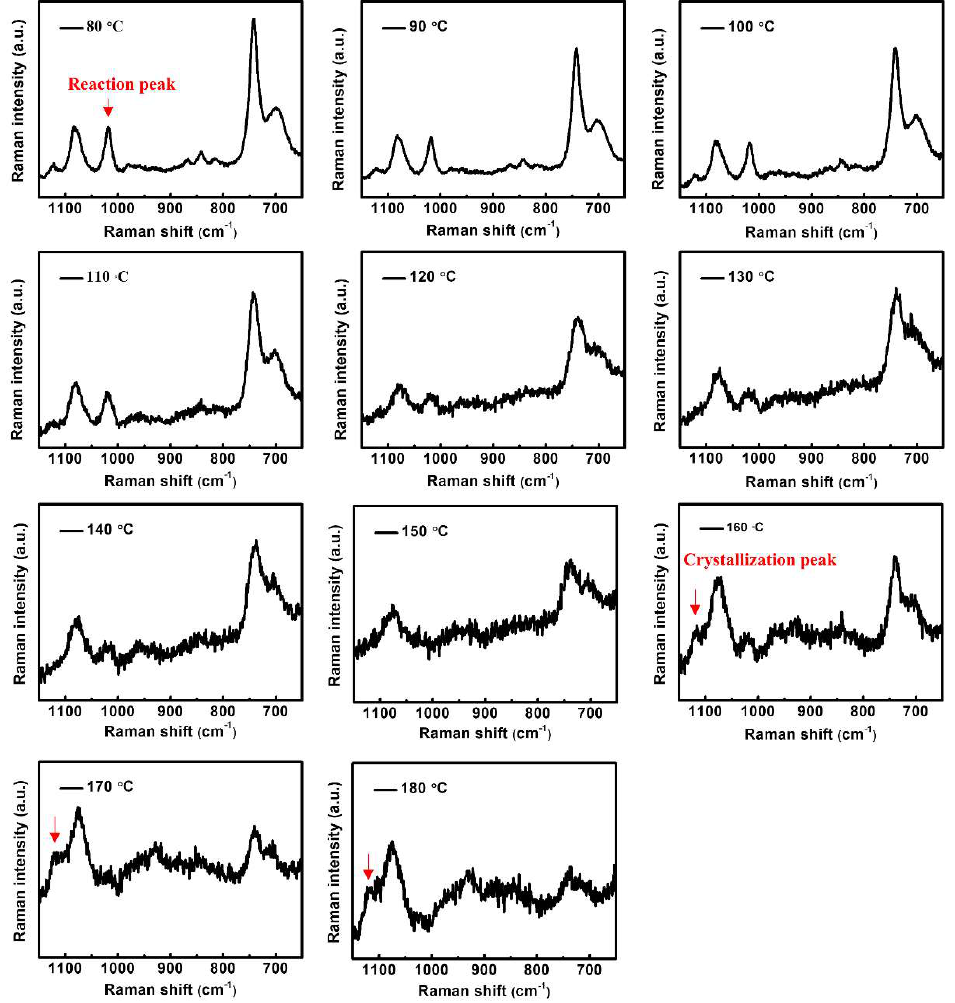
Figure 6. Raman spectra of caprolactam from 80 °C to 180 °C at heating rate of 5 °C/min.